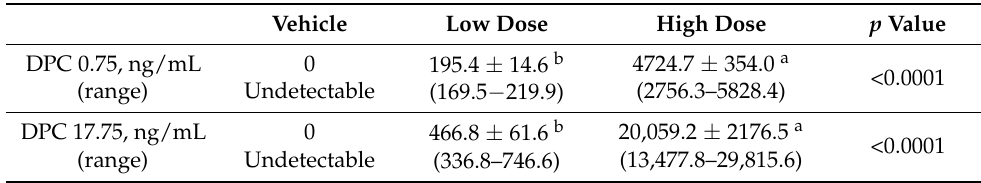
Table 1. Serum concentrations of fluoxetine + norfluoxetine in pregnant mice on DPC 0.75 and 17.75 (6 h after the first and 18th treatments, respectively).